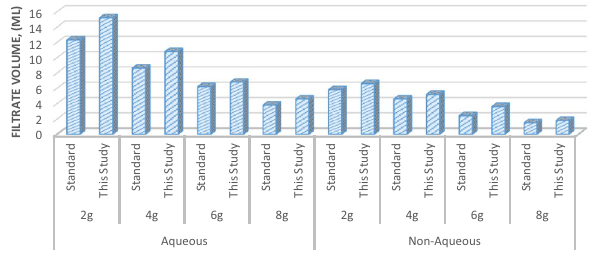
Fig. 4 The filtration volume from the filtration test for aqueous and non-aqueous drilling mud systems compared with standard